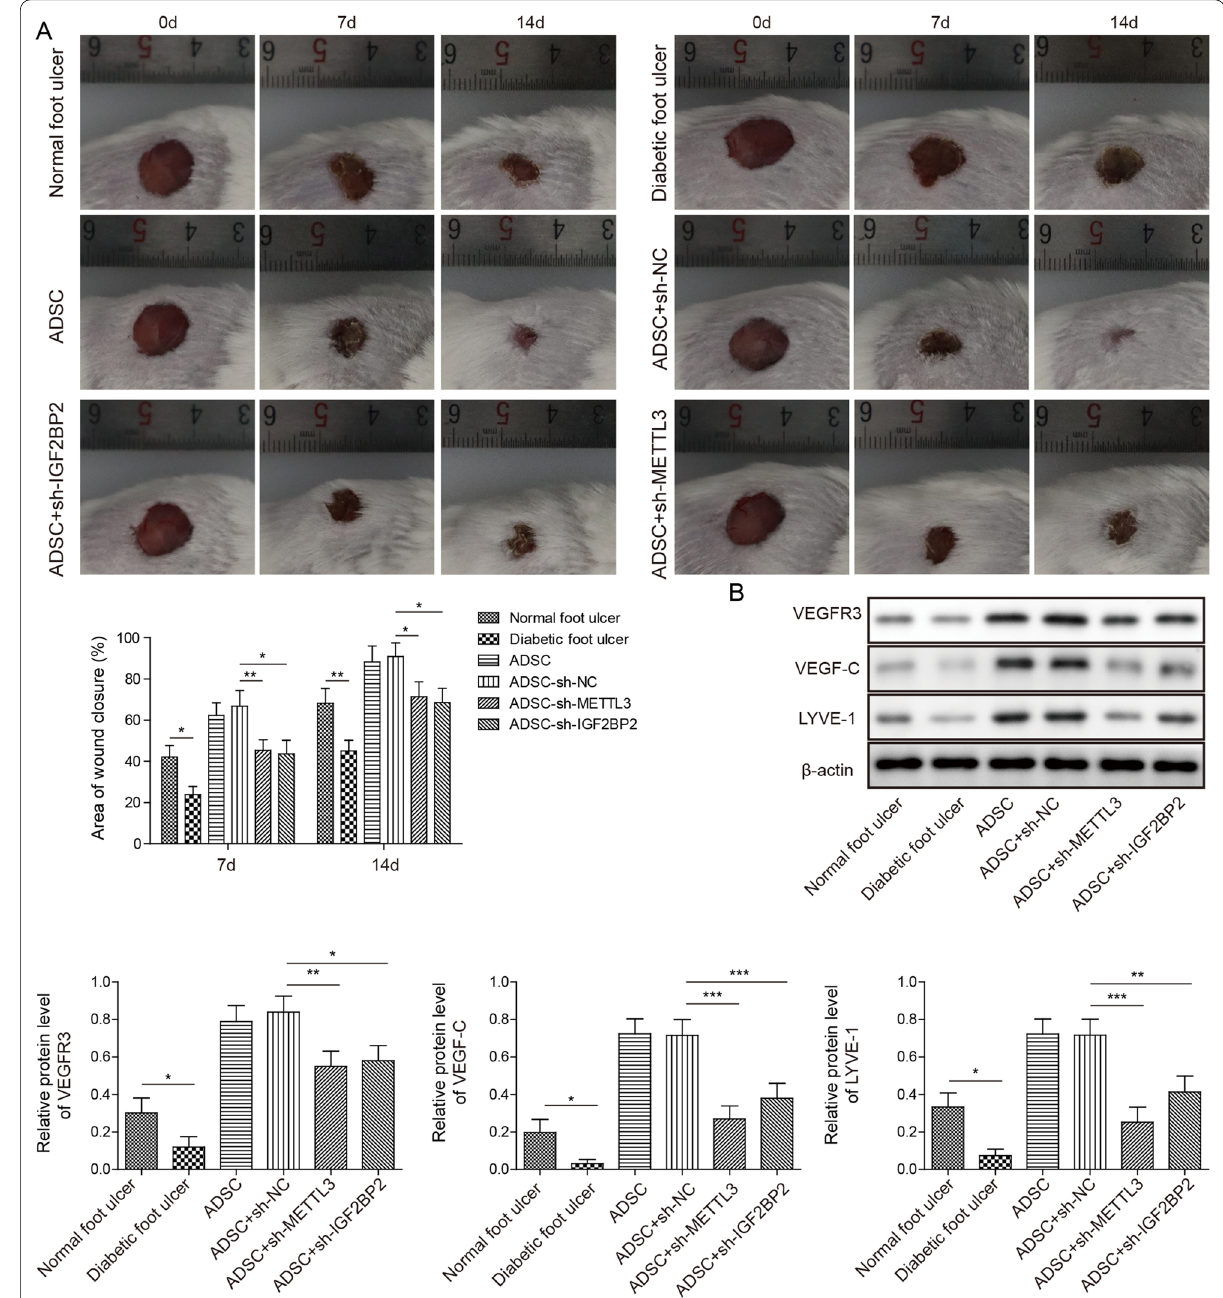
Fig. 5 ADSCs regulate VEGF-C-mediated lymphangiogenesis and macrophage infiltration via the METTL3/IGF2BP2-m 6 A pathway in DFU mice. Sh-METTL3 or sh-IGF2BP2 plasmids were transfected into ADSCs for METTL3 or IGF2BP2 knockdown. sh-NC served as the negative control for sh-METTL3 or sh-IGF2BP2. Subsequently, untreated ADSCs or transfected ADSCs were injected into DFU mice. (N of DFU mice. B Western blotting was conducted to detect the protein levels of VEGFR3, VEGF-C and LYVE-1. Data represent the mean of five independent experiments. Error bars represent SD. * P < 0.05, ** P < 0.01 or *** P <